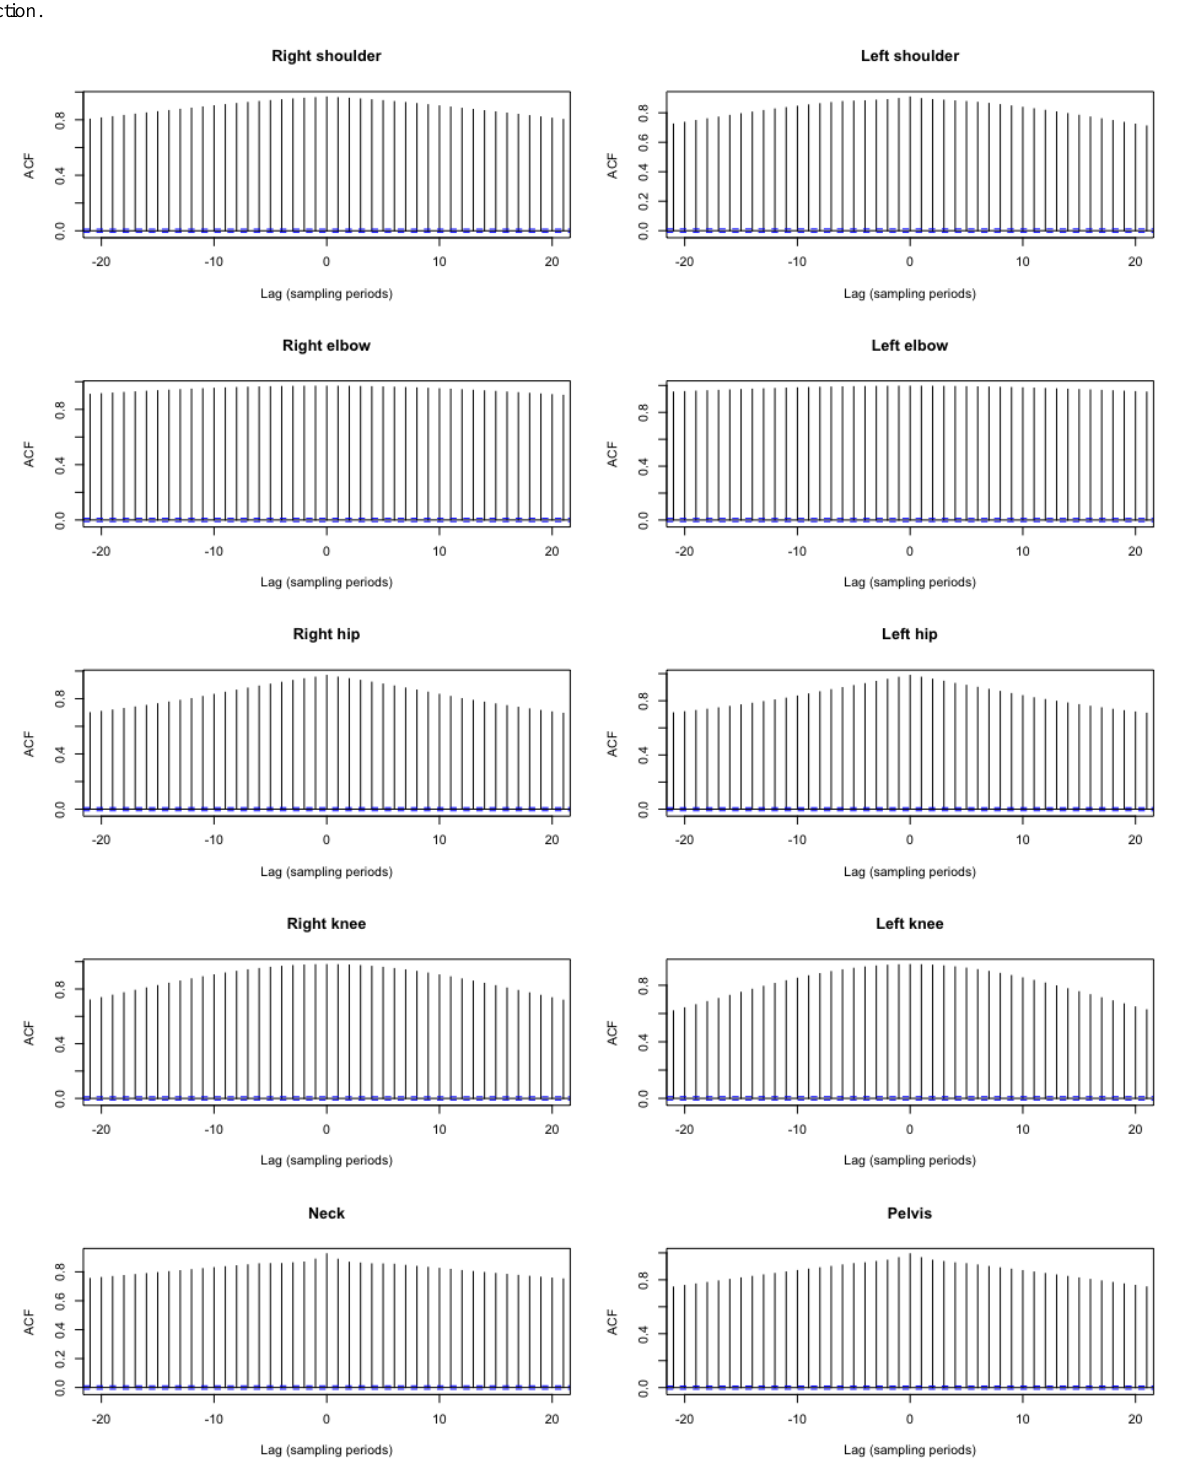
Figure 5. Cross-correlation graph of Lindera-v2 and Panoptic Studio data set values. One lag represents 1 sample (frame). ACF: autocorrelation